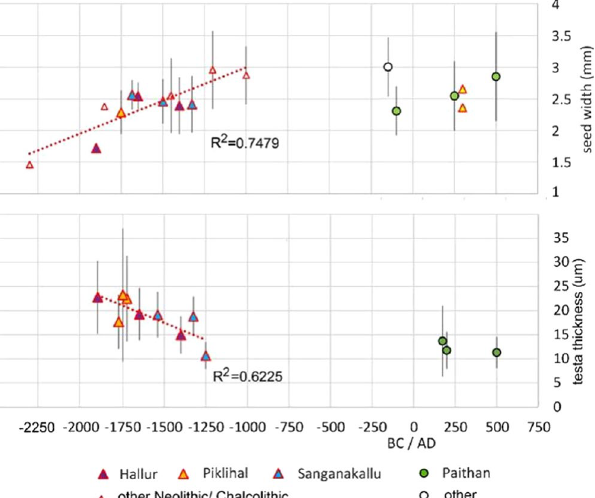
Figure 3. Change in seed size and seed coat thickness over time in Southern Indian archaeological horsegram. Top graph show mean and standard deviation of seed width (data: Table S2). Lower graph shows testa thickness mean and standard deviation (data: Table S3). Trend lines through Neolithic/Chalcolithic samples indicates the trend during the domestication